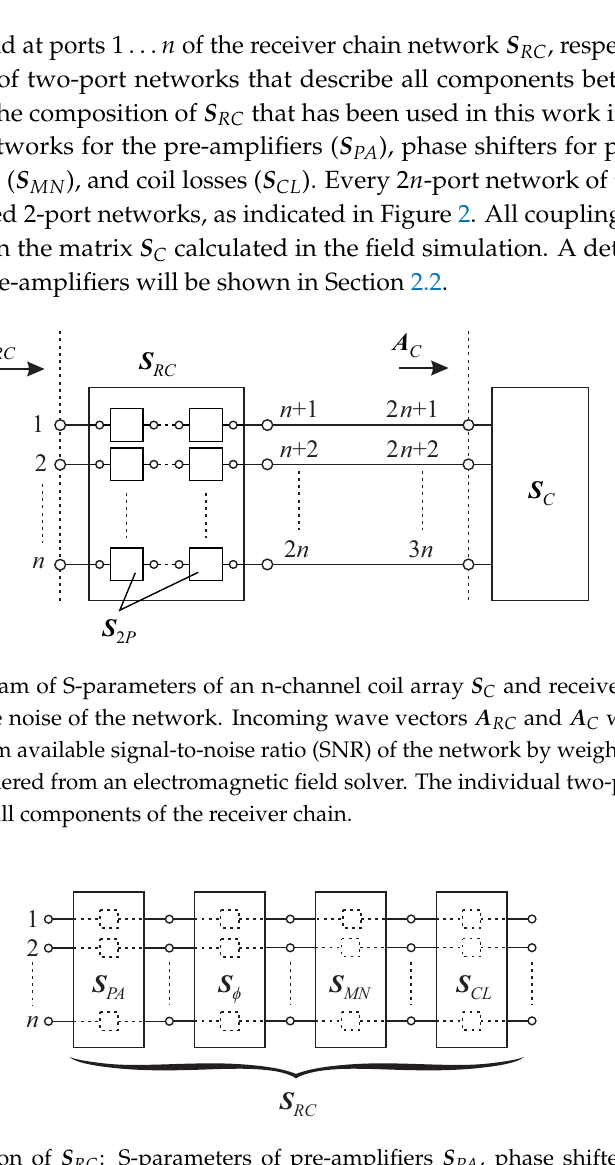
Figure 2. Composition of S RC : S-parameters of pre-amplifiers S PA , phase shifters S φ , matching networks S MN , and coil losses S CL